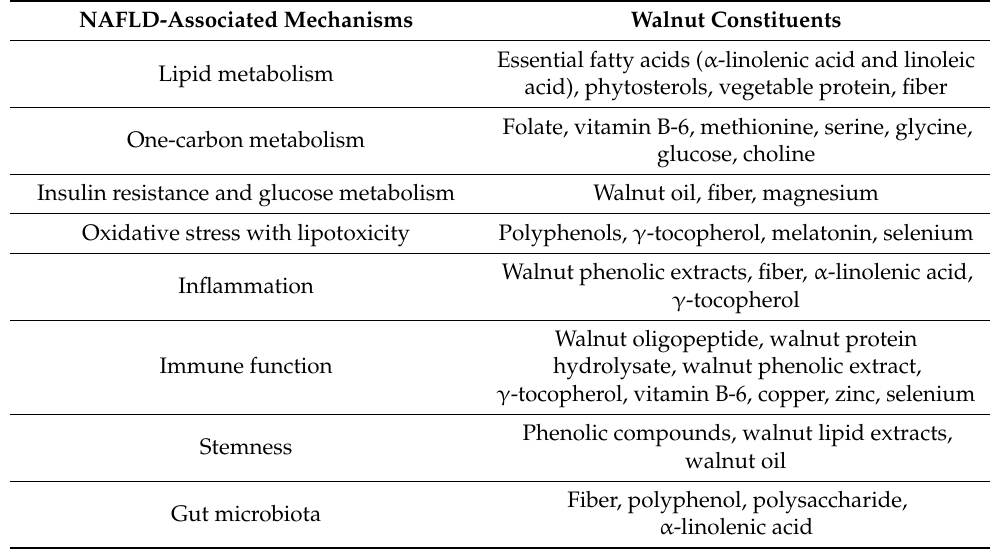
Table 2. Walnut constituents that target the NAFLD-associated pathophysiologic